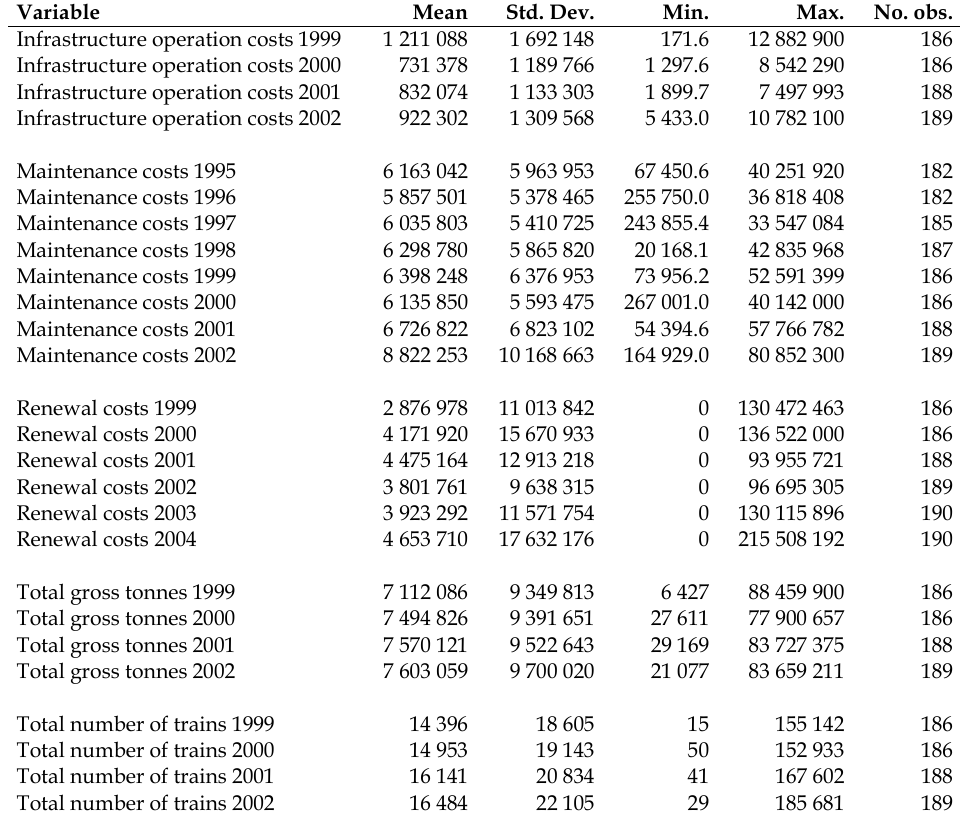
Table 1. Cost and traffic data